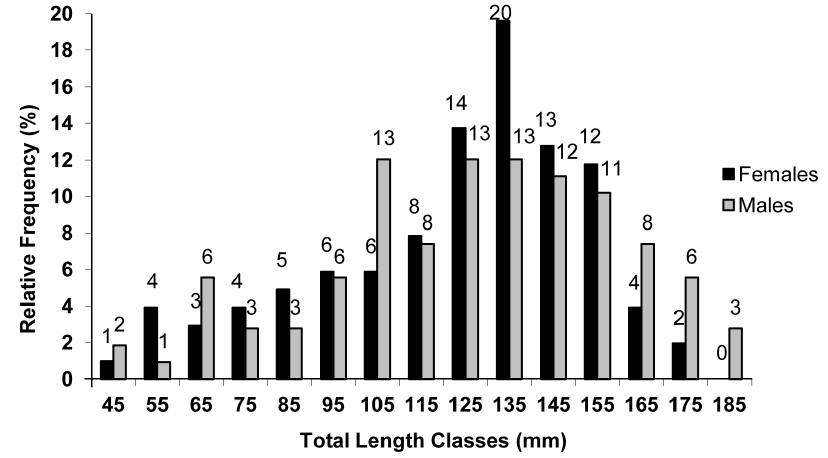
Figure 5. Total length classes. Distribution of the relative frequency of males and females of Brachyhypopomus gauderio assigned to total length classes (10 mm total length). Black columns represent females, and grey columns represent males. Numbers above the columns correspond to the absolute values.